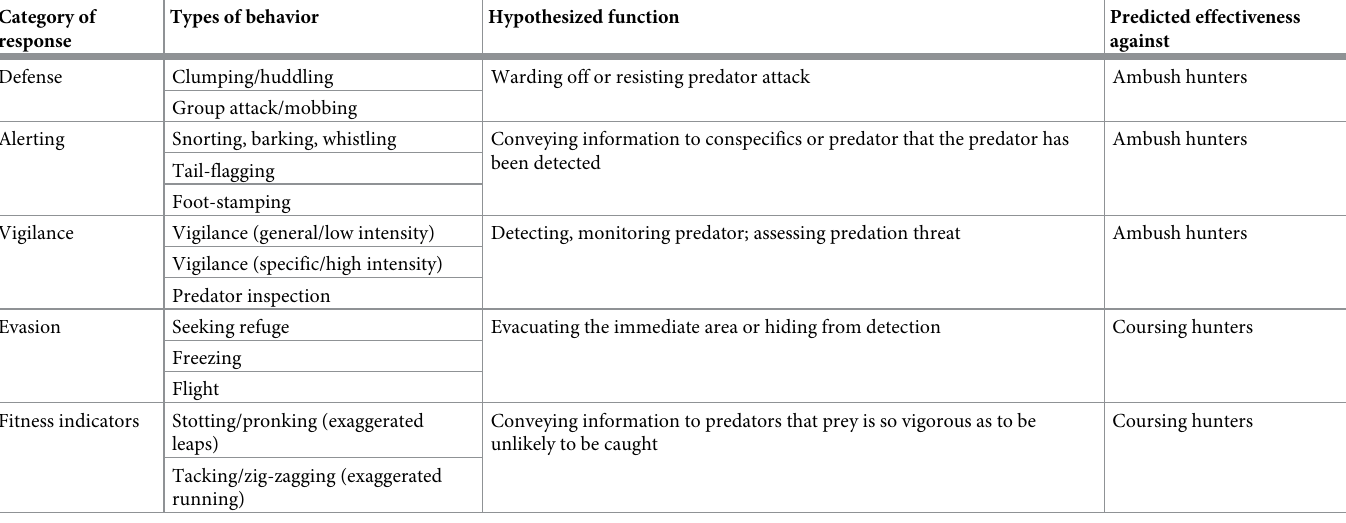
Table 1. Reactive anti-predator behaviors performed by large terrestrial mammals when encountering predators, their hypothesized adaptive functions (adapted from [20]), and predictions of the most effective response to each hunting style. Category of